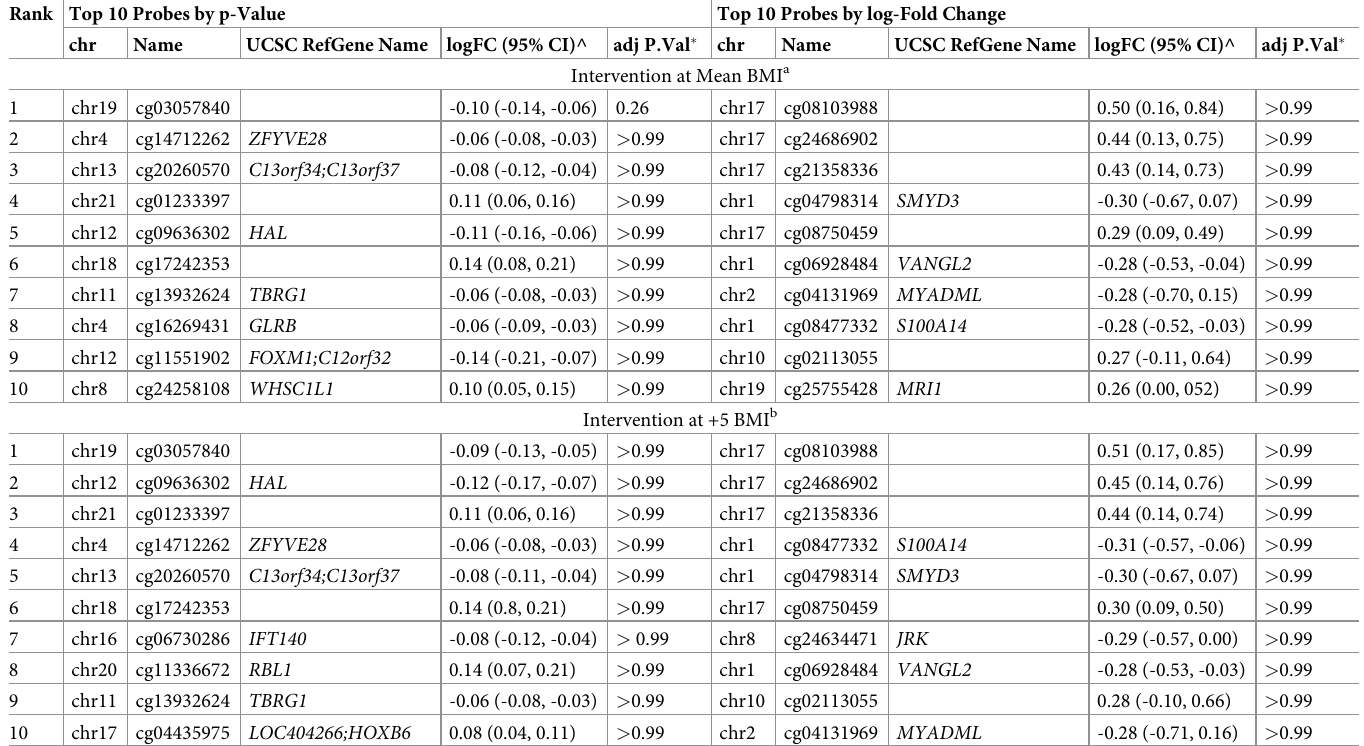
Table 2. Top 10 differentially methylated probes (lifestyle advice vs standard